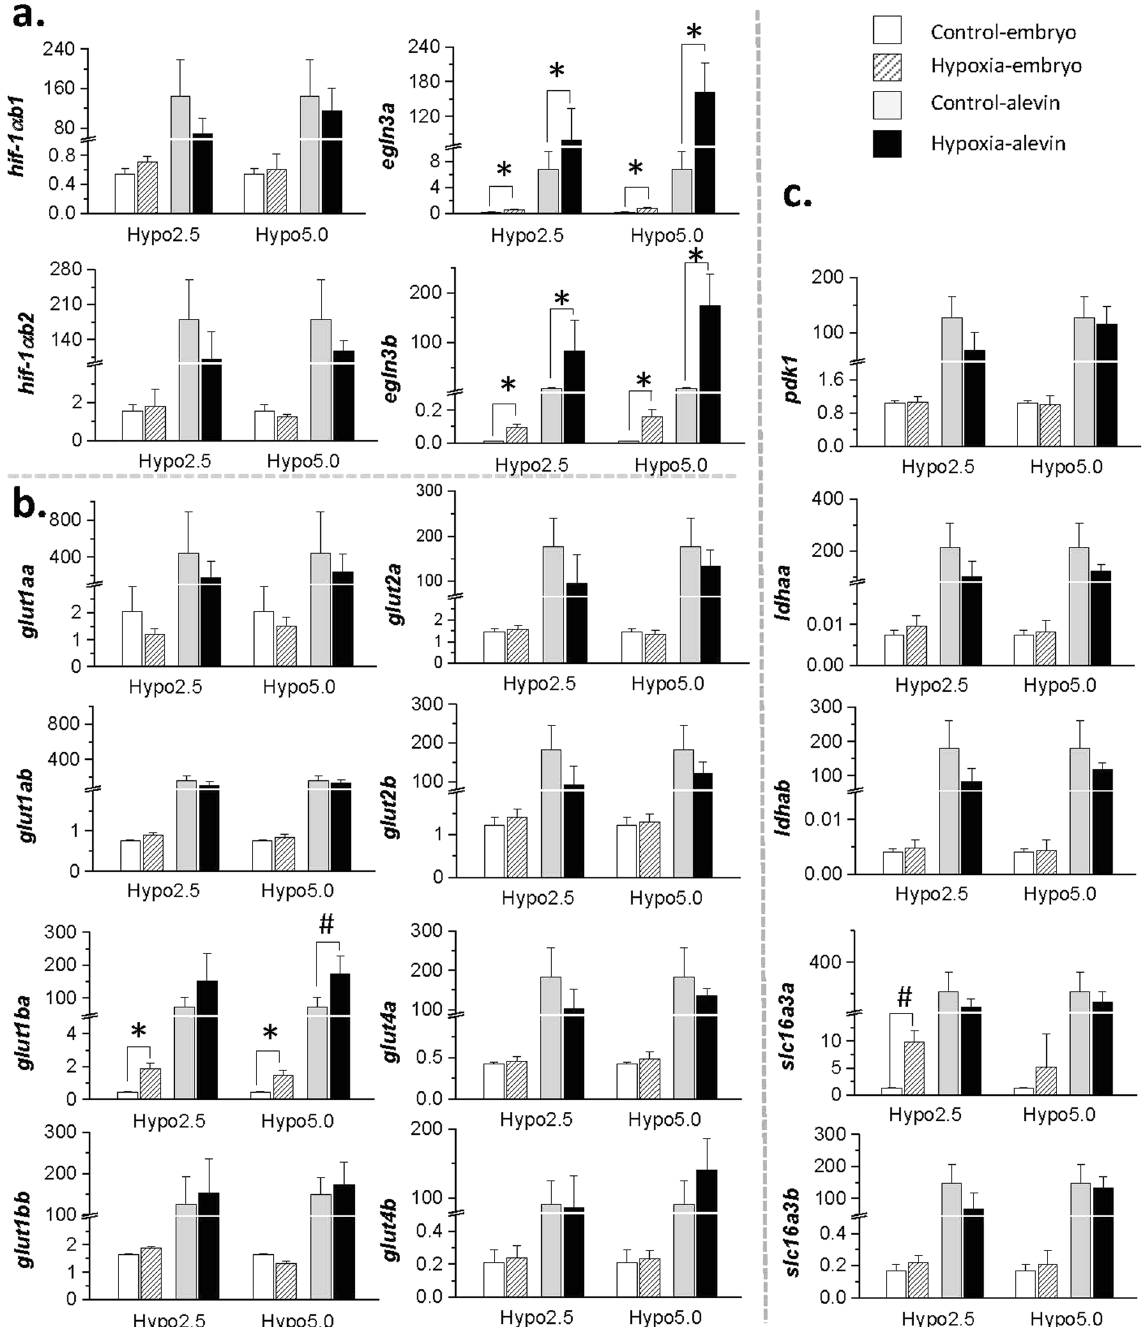
Figure 1. Molecular confirmation of the effect of the hypoxic stimulus on targeted oxygen-sensitive genes in non-hatched embryos and early hatched alevins. The relative abundance of mRNA of ( a ) hypoxia-responsive genes, ( b ) glucose transport genes and ( c ) pyruvate conversion and lactate transport genes in embryos (kept under normoxia, white bars; exposed to hypoxia, slash bars) and in alevins (kept under normoxia, grey bars; exposed to hypoxia, black bars). Data are presented as the mean ± SD (n = 6), significant differences were evaluated by nonparametric Kruskal-Wallis test followed by a Tukey’s test ( # p < 0.05; * p <